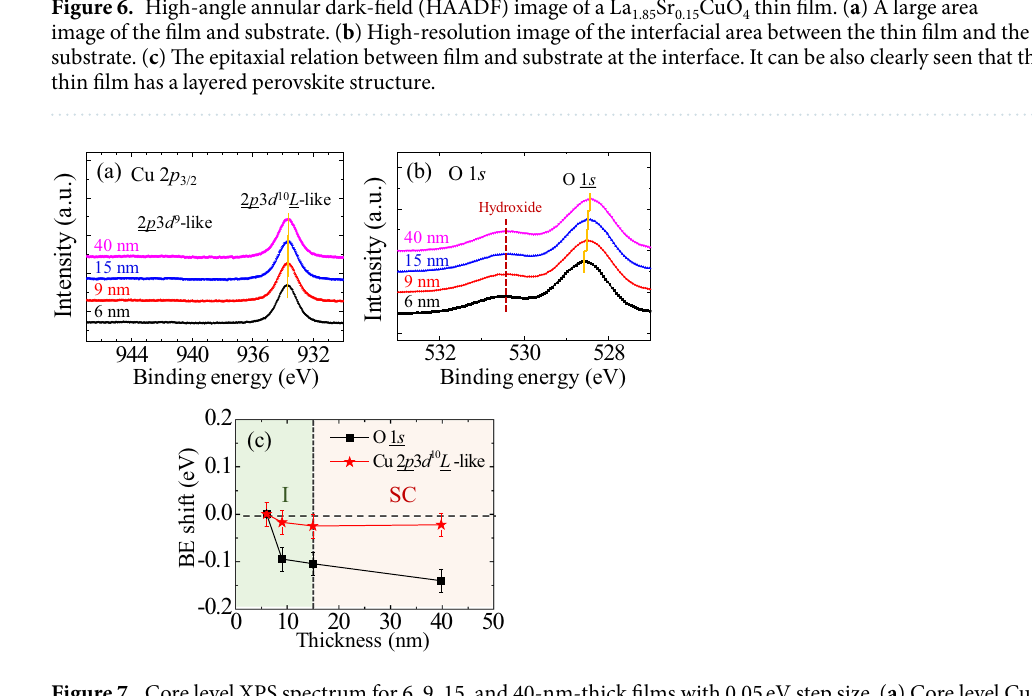
Figure 7. Core level XPS spectrum for 6, 9, 15, and 40-nm-thick films with 0.05 eV step size. ( a ) Core level Cu 2 p 3/2 XPS spectra. The main and suppressed satellite peaks correspond to 2 p 3 d 10 L -like and 2 p 3 d 9 -like states, respectively. Yellow guide line indicates the peak centers of 2 p 3 d 10 L -like states. ( b ) O 1 s core XPS spectra. The yellow guide lines indicate the peak centers of O 1 s peaks. Wine dashed line indicates the surface hydroxide peaks. ( c ) Binding energy shifts of O 1 s and Cu 2 p 3/2 core levels relative to those of the 6-nm-thick film. Error bar represents a measurement step of ± 0.025